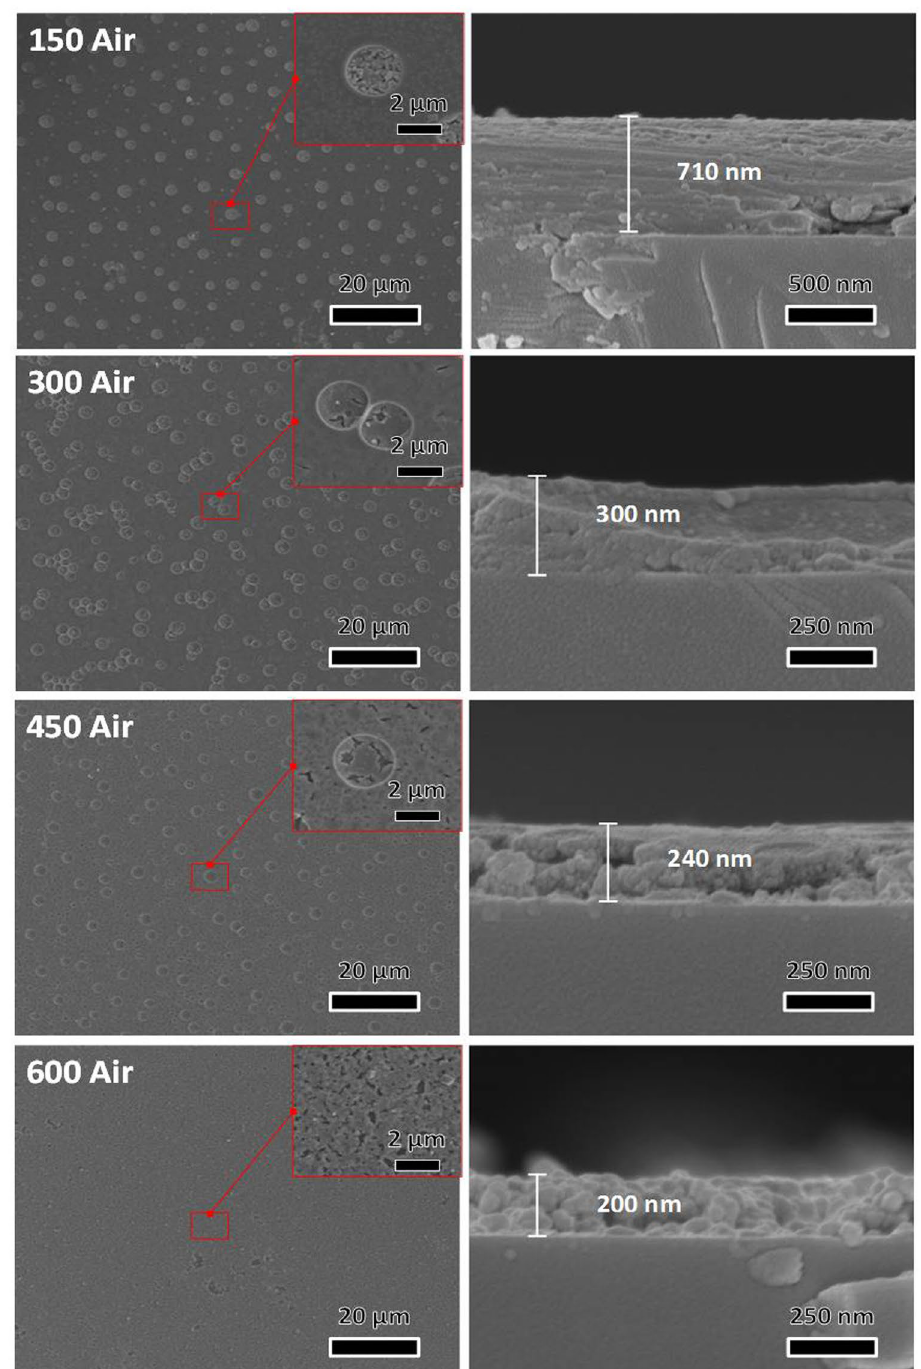
Figure 5. Surface and cross-sectional SEM images of samples annealed in Air atmosphere with different temperature in the range 150 to 600